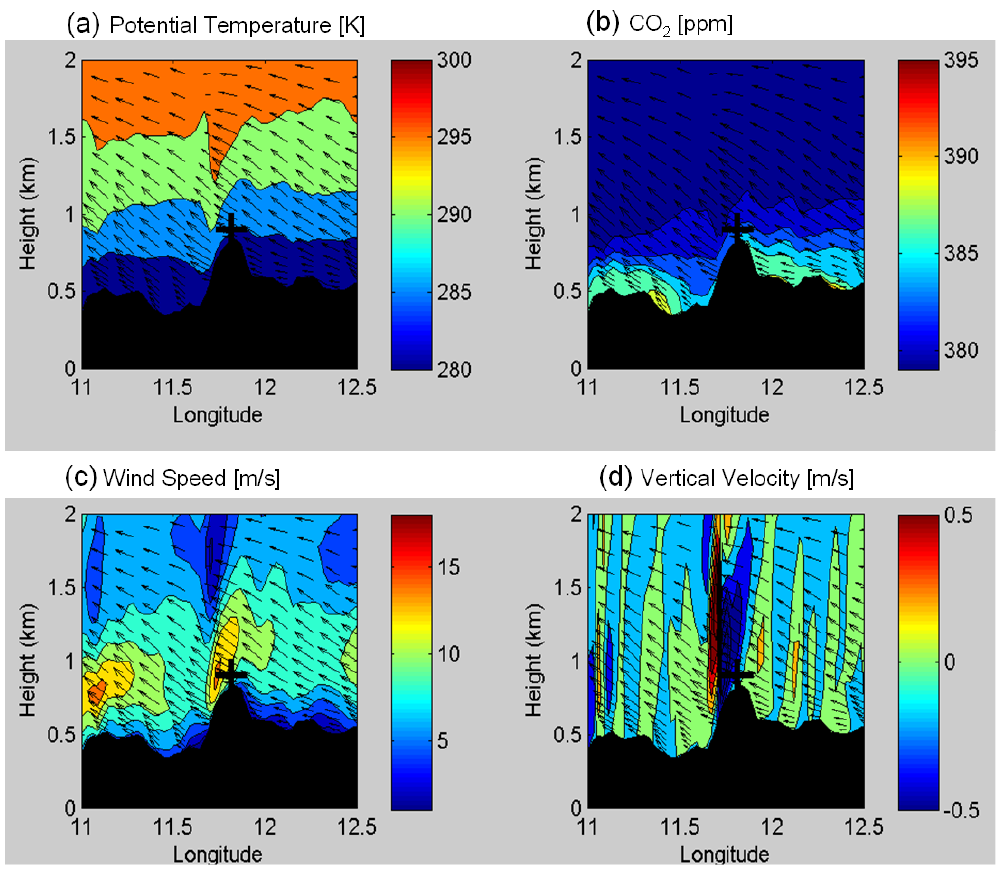
Fig. 12. Vertical cross section along OXK latitude (50 ◦ 01”N) on 17 October 2006 at 02:00UTC, showing WRF-VPRM simulated (a) Po- tential temperature in Kelvin (b) CO 2 concentration in ppm (c) Wind speed in ms − 1 and (d) Vertical velocity in ms − 1 . The overlaid arrows indicate wind direction at different Figure 12. Vertical cross section along OXK latitude (50 0 01" N) on 17 th October 2006 at 02:00 UTC, showing WRF-VPRM simulated a) Potential temperature in Kelvin b) CO concentration in ppm c) Wind speed in ms -1 and d) Vertical velocity in ms -1 arrows indicate wind direction at different altitudes.